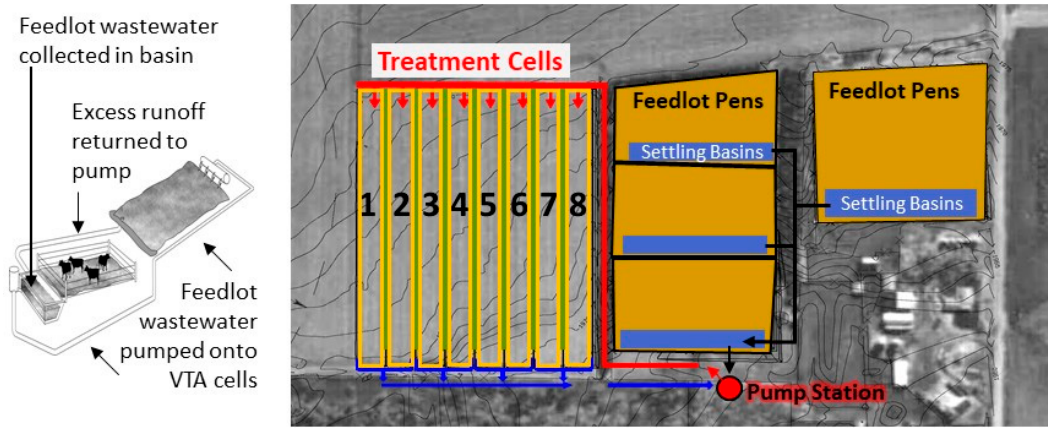
Figure 1. Vegetative Treatment System (VTS) design at beef cattle feedlot site. Feedlot runoff from